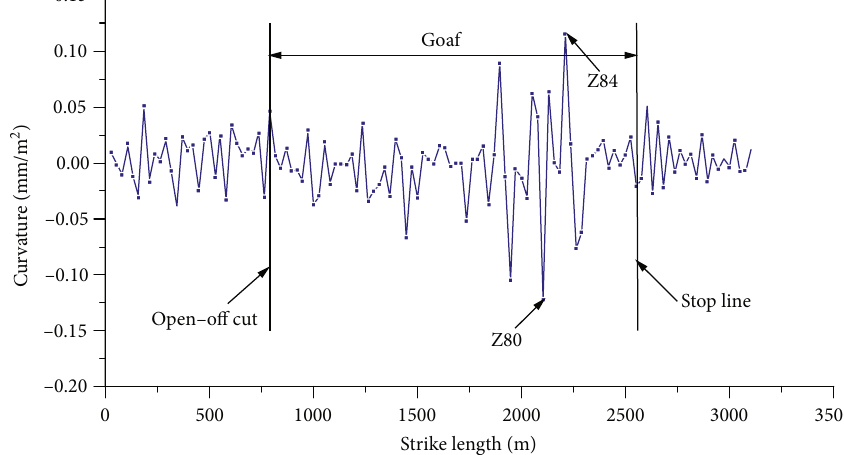
Figure 4: Surface curvature curve of 1301 working face towards main